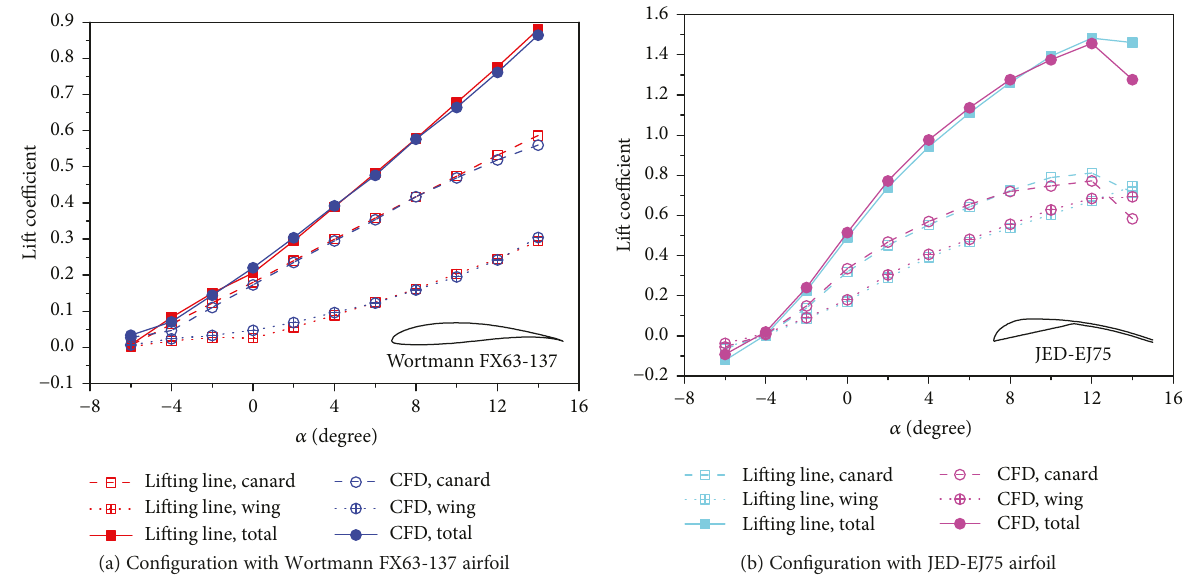
Figure 10: Validation for di ff erent tandem wing con fi